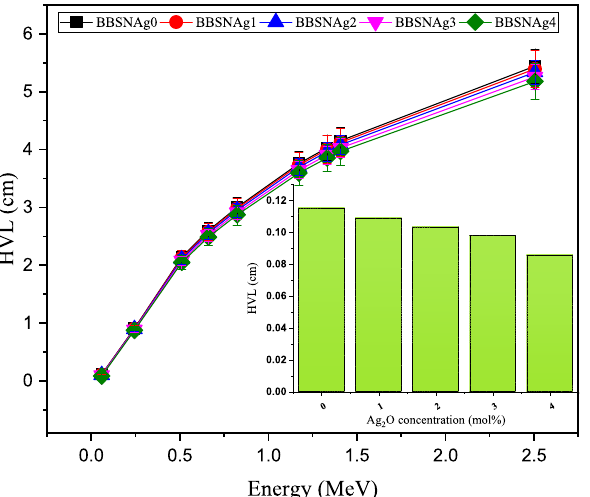
Figure 12. Variation of the half-value layer of the fabricated glasses at various gamma-ray energies.